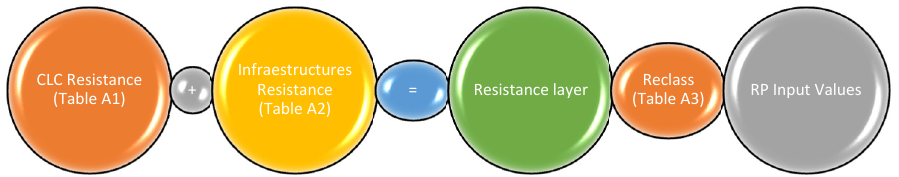
Figure 2. Schematic of Resistance Layer Calculation and reclassification into RP input values.